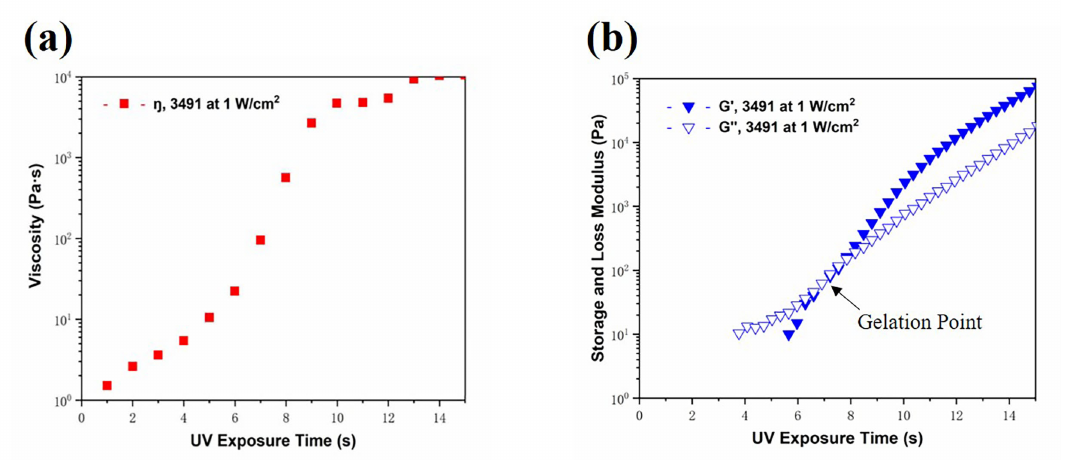
Figure 4. UV rheological characterization results: ( a ) viscosity as a function of UV exposure time (365 nm, 1 W/cm 2 ); and ( b ) moduli as a function of UV exposure time (365 nm, 1 W/cm 2 ). The gelation point is defined as the cross over point of the storage modulus G’ and the loss modulus G”.